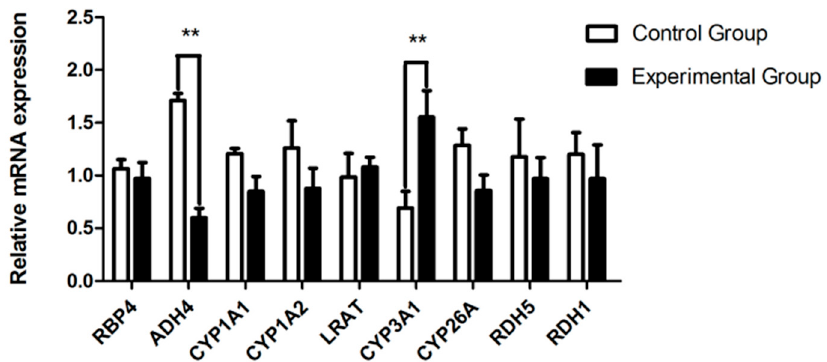
Figure 11. qRT-PCR validation of retinol metabolism related genes. The expression of selected genes was normalized to β -actin. *, p < 0.05; **, p < 0.01.